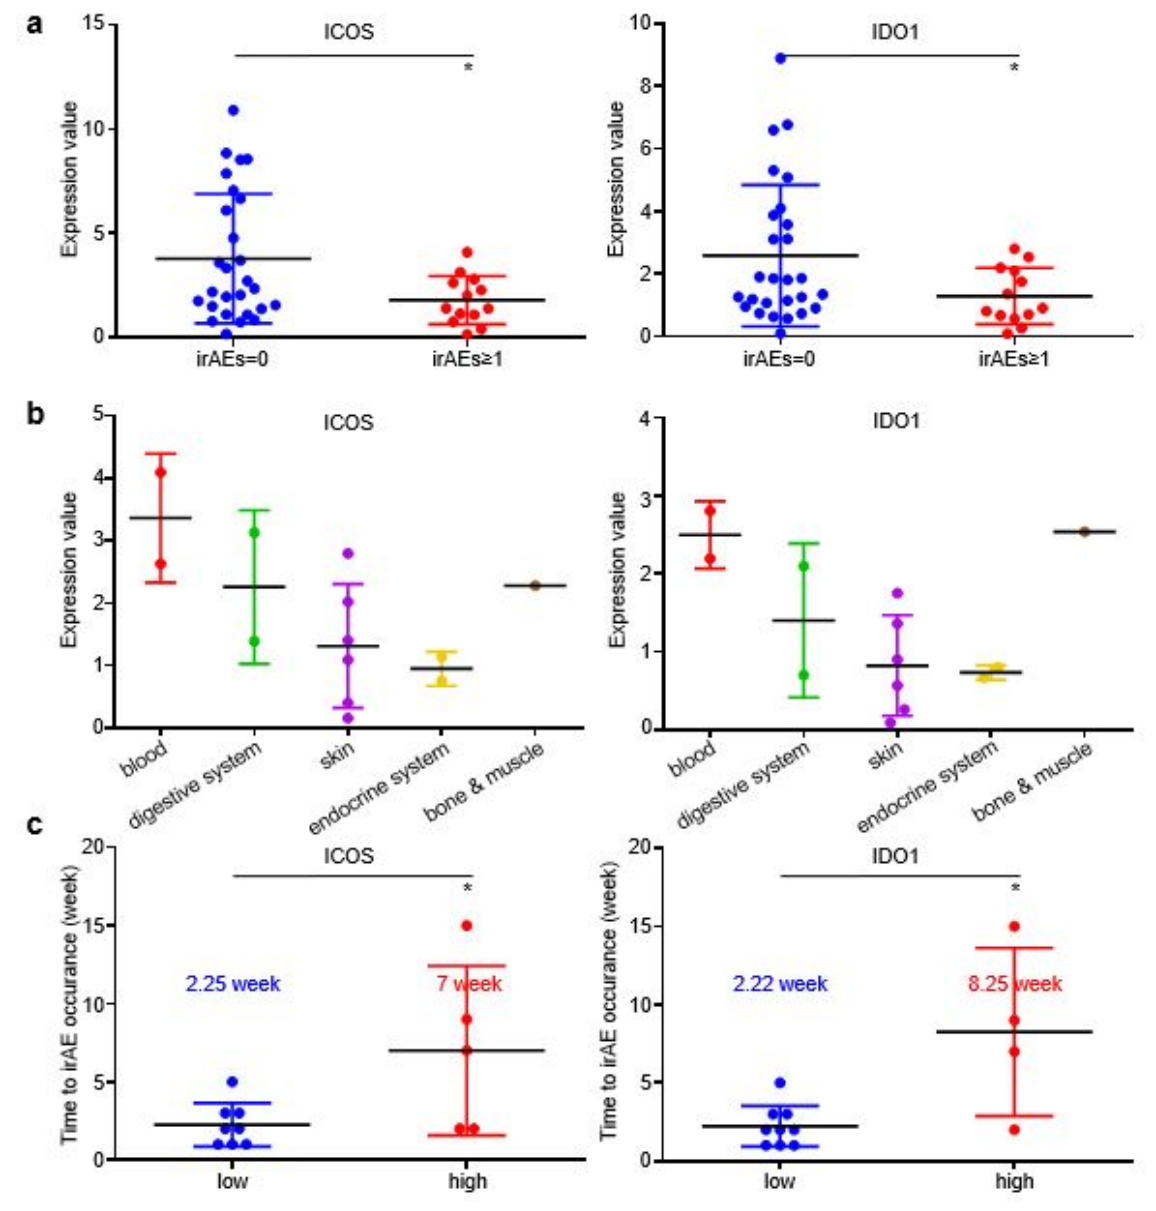
Figure 5. EV-ICOS/IDO1 remained as predictors for irAEs in validating cohort. ( a ) The baseline expression value of EV-ICOS/IDO1 was lower in irAEs groups. ( b ) EV-ICOS/IDO1 had no correlation with the distribution of irAEs organs/systems. ( c ) Patients with high ICOS/IDO1 had a later onset of irAEs. (* p < 0.05).